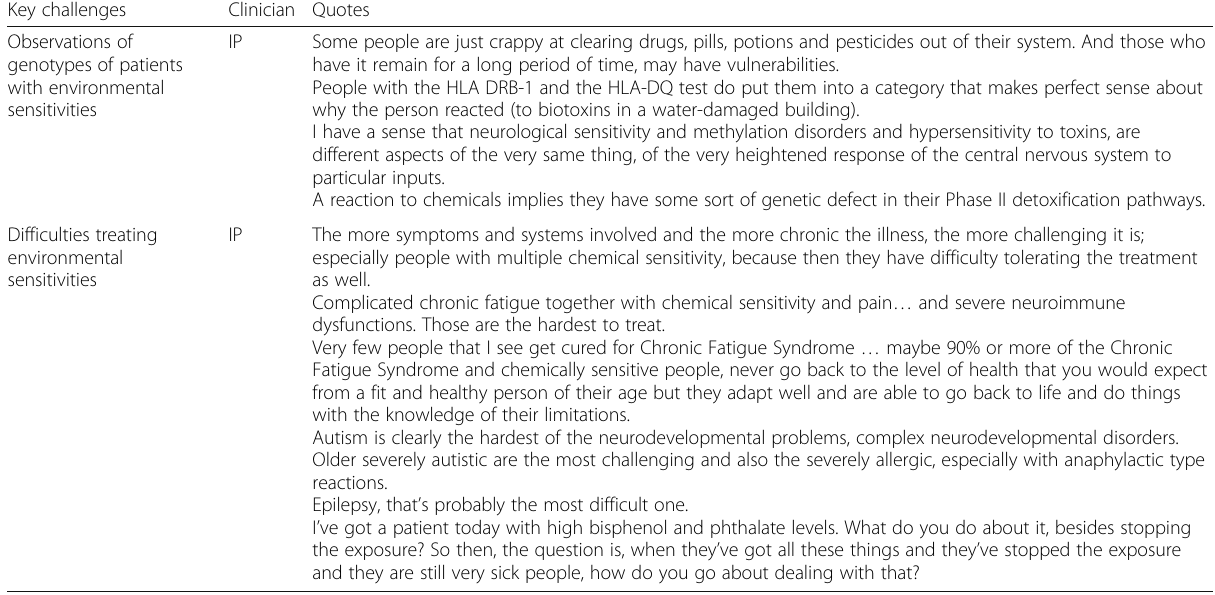
Table 4 Patients with environmental sensitivities have unique phenotypes, are complex to treat, rarely regain full health and are becoming more prevalent (Continued)